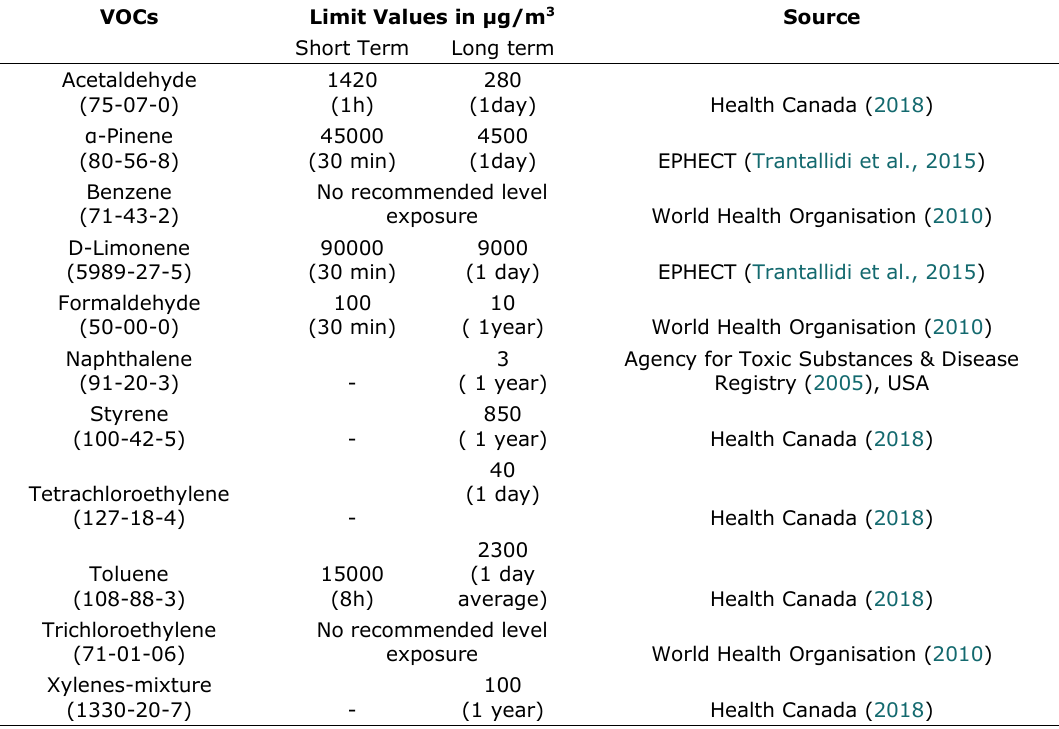
Table 3. Indoor air quality guidelines for selected VOCs (Public Health England,